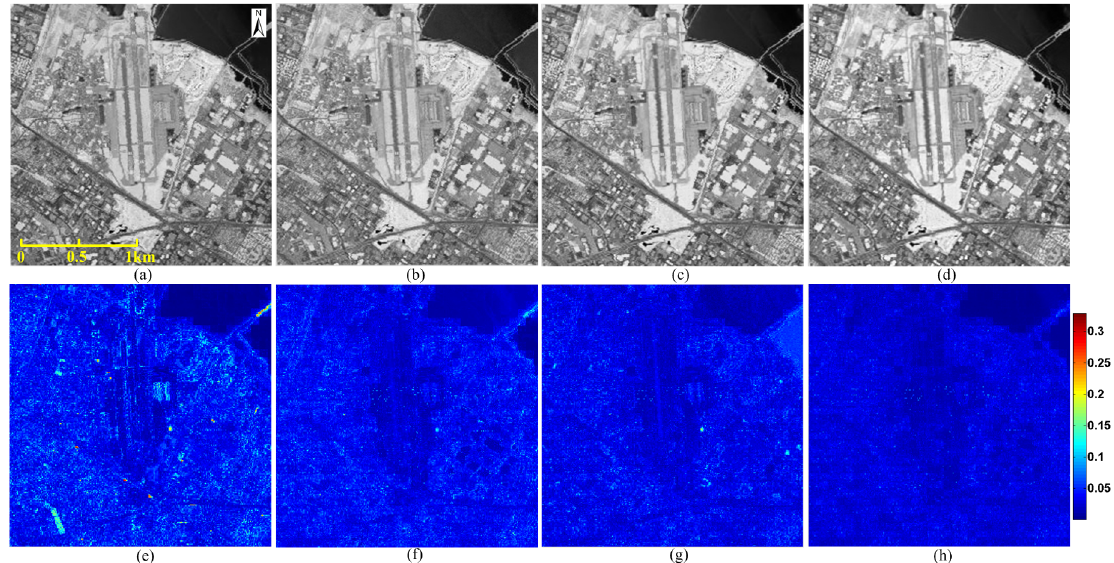
Figure 6. Reconstructed images (band 70) and root mean square error (RMSE) maps of different fusion results by a factor of four. The testing image is cropped from Indian pines of AVIRIS data with size 256 × 256. ( a ) result of SSR [12]; ( b ) result of BayesSR [13]; ( c ) result of CNMF [6]; ( d ) result of Two-CNN- Fu; ( e ) RMSE map of SSR [12]; ( f ) RMSE map of BayesSR [13]; ( g ) RMSE map of CNMF [6]; ( h ) RMSE map of Two-CNN-Fu.